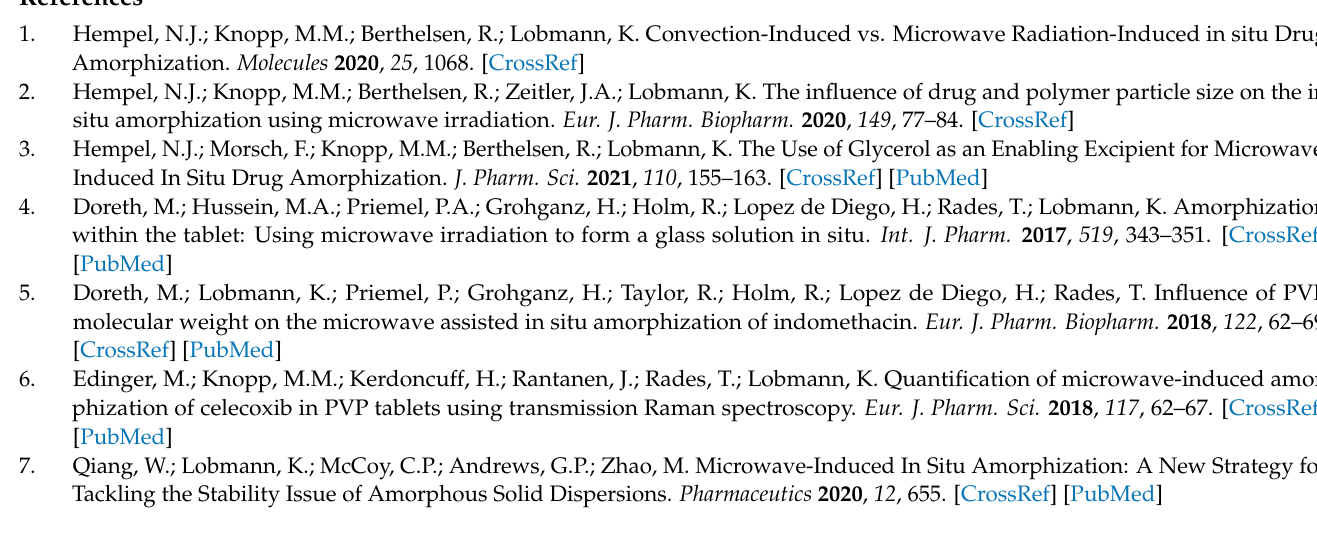
Figure S1: XRP-diffractograms, Figure S2: Temperature